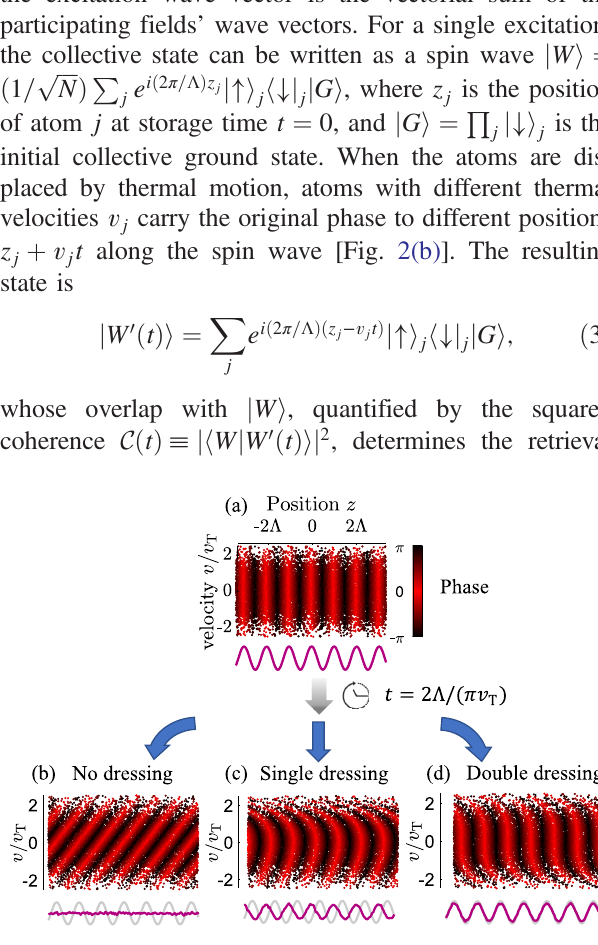
FIG. 2. Motional dephasing and protection of a spin wave. (a) Position-velocity representation of a collective excitation (spin wave), generated, e.g., by light storage in a two-photon bichromatic transition. The collective state has a spatially dependent phase with a wavelength Λ (top), clearly apparent when the real part of the spin wave is averaged over all velocities (purple, bottom). (b) Thermal atomic motion (mean velocity v ) T at time t ¼ 2 Λ = ð π v after the initial excitation. Averaging over T Þ velocities results in decoherence of the collective state. (c) Atoms with different velocities experiencing different light shifts in the presence of a single dressing field, and spatial coherence maintained up to second order in velocity. The zeroth-order term introduces a global phase shift, which is evident when comparing the spin wave (purple) to its original form (gray). (d) Protection up to third order in velocity (thus covering a wider velocity range) when two dressing fields are applied, with no global phase shift introduced. Calculations are performed with s ¼ 110 , Δ ¼ 4 v = Λ , and optimal Ω from Eqs. (1) and T